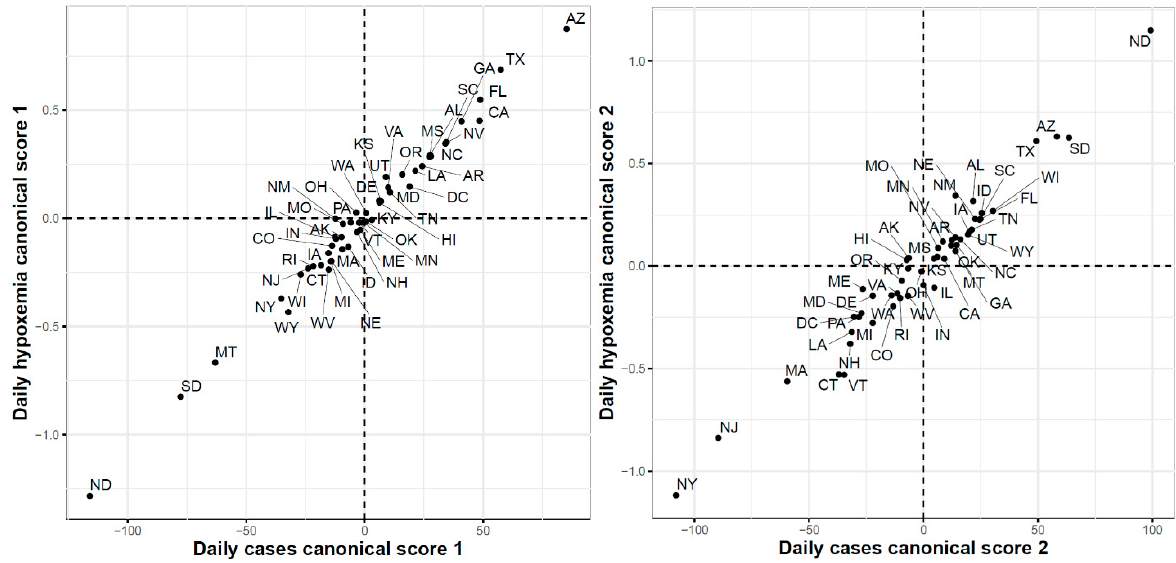
Figure 17. First ( left ) and second ( right ) functional canonical variables scores of the COVID-19 confirmed cases versus the Google daily searches for